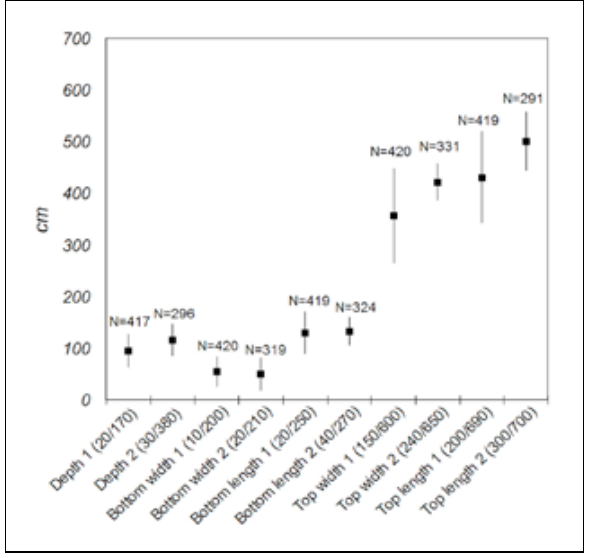
Fig. 6. Mean + standard deviation of pitfall dimensions in the Dovrefjell - (1) and Fagerhaug (2) systems ( N =418/26). Min. and max. values in cm are shown in